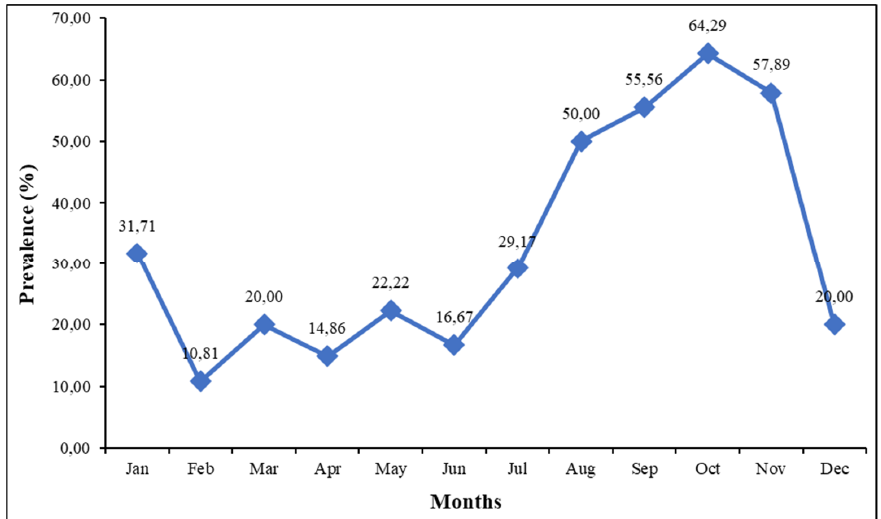
Figure 3. The monthly prevalence of Cryptosporidium species infection among cattle in Kwara